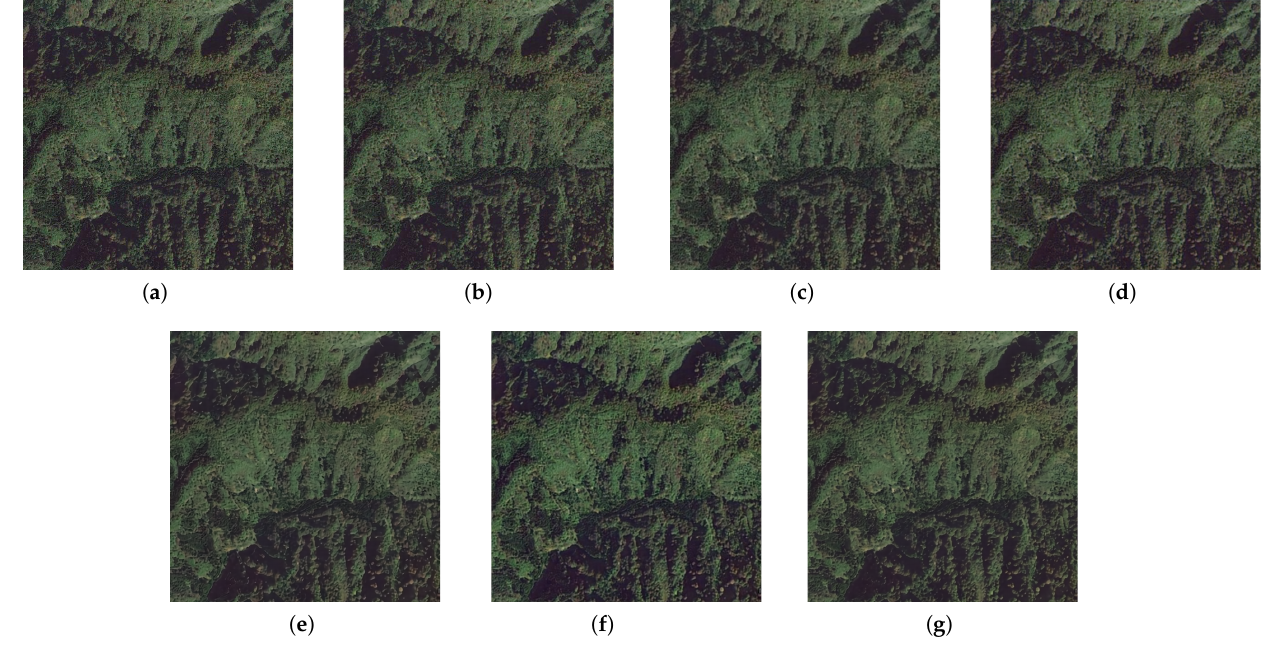
Figure 11. Comparison of visual results of different SR methods with × 2 super-resolution on the WHU-RS19 [40] dataset (forest scene). ( a ) HR. ( b ) Bicubic. ( c ) EDSR [68]. ( d ) RCAN [81]. ( e ) RDN [64]. ( f ) SAN [83]. ( g ) NLSN [88].